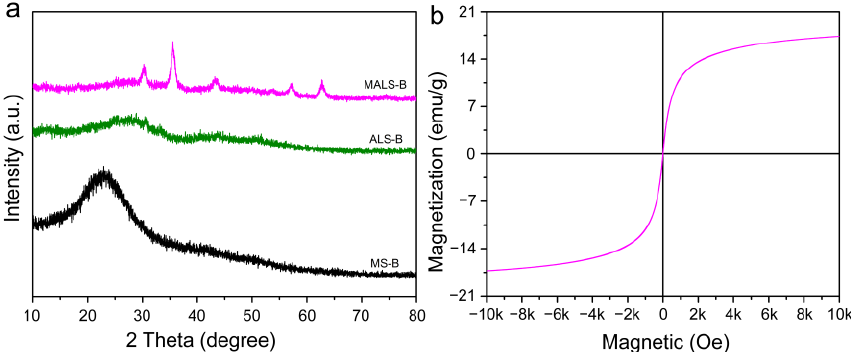
Figure 4. ( a ) XRD patterns of the synthesized hydrogel beads; ( b ) magnetic hysteresis curve of MALS-B.